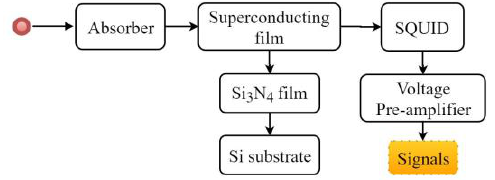
Fig. 1. The main components of the TES. Also, the measurement process is